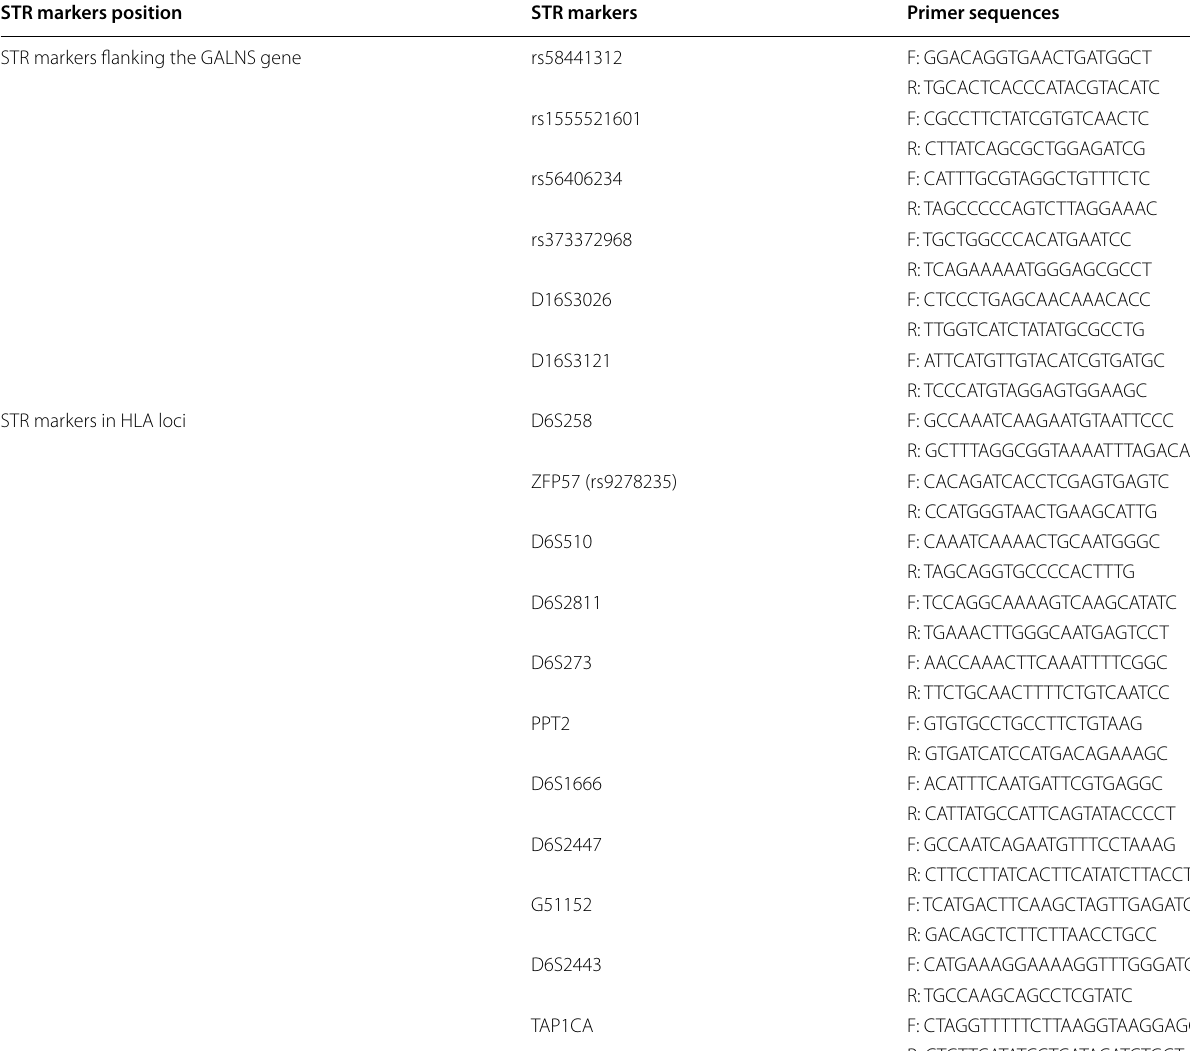
Table 1 The primers for STR markers flanking the GALNS gene or in HLA loci STR markers position STR markers flanking the GALNS gene